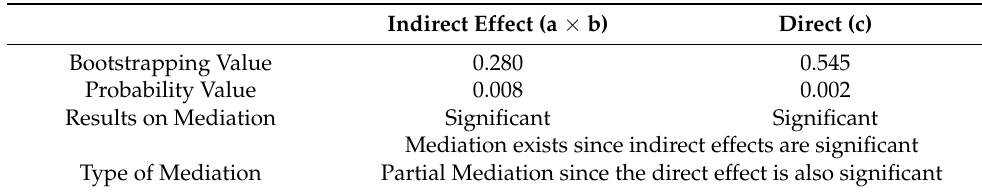
Figure 6. Path analysis of direct and indirect effect tested. Table 6. Result of bootstrapping analysis for mediator analysis.